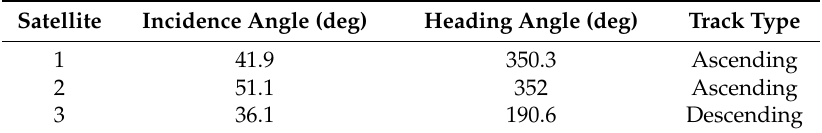
Table 6. Parameters of each satellite in [8].